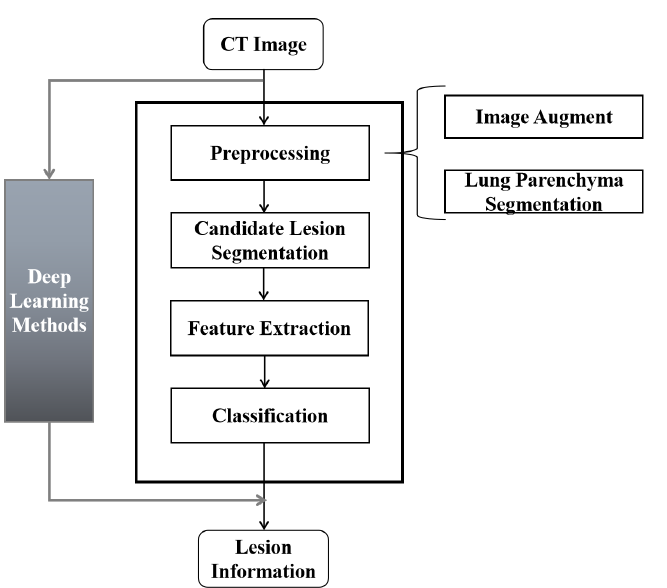
Figure 2. The framework of CISs detection. The traditional multistep framework as shown in the black rectangular box involves four fundamental steps: preprocessing, candidate region segmentation, feature extraction, and false positive reduction. The innovative deep learning detection framework is shown in the gray